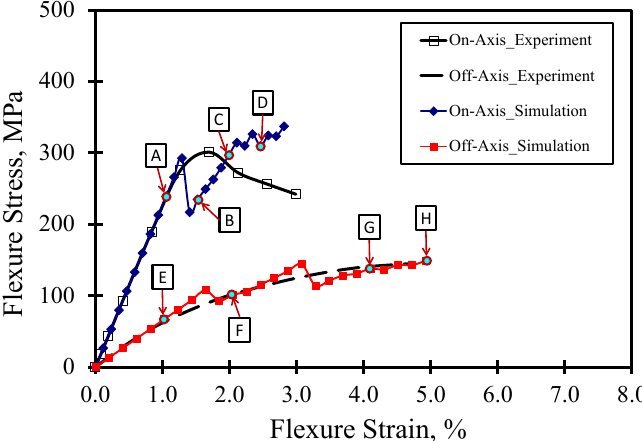
Figure 6. Comparison between experiment and FE simulation for on- and off-axis flexure